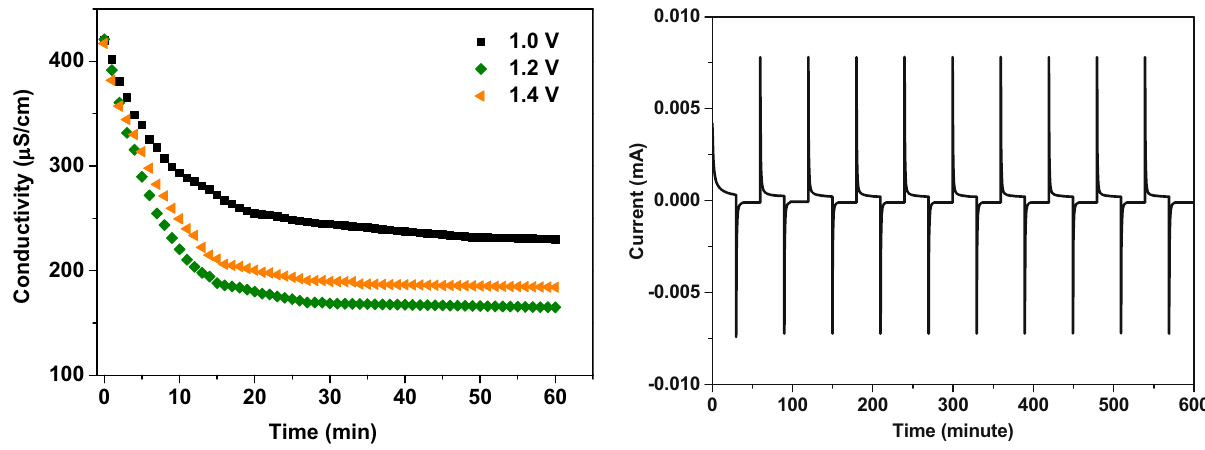
Figure 7: CA curve of adsorption/desorption process for ten cycles at 1.2 V of mAC/Gt/PVA - GA/Ti electrode in NaCl solution 200